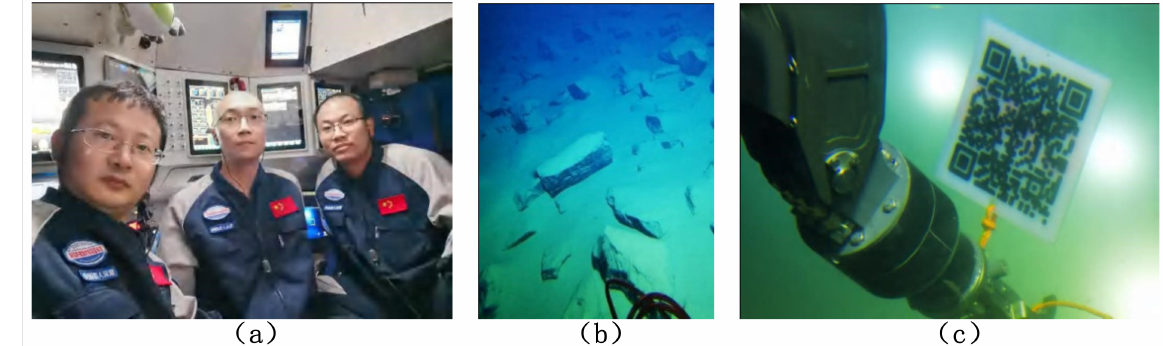
Figure 15. Pictures sent by the Fendouzhe HOV using the underwater acoustic communication system at the depth of 10,000 m: ( a ) diver images ( b ) image of the Mariana Trench bottom and ( c ) manipulator operation.